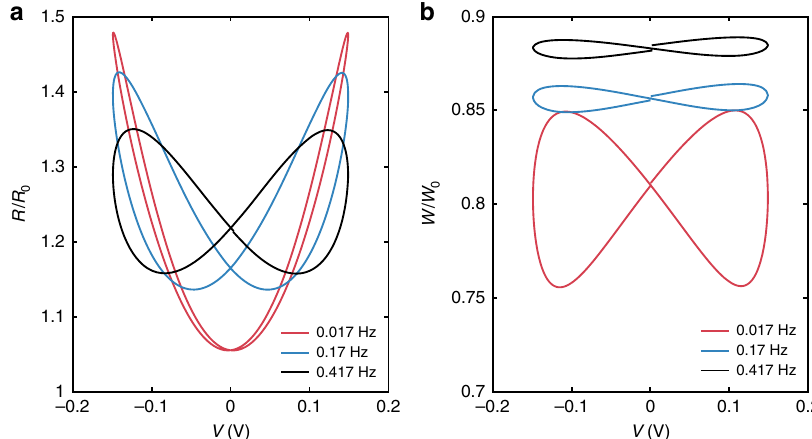
Fig. 7 Pinched hysteresis in state variable-voltage relationships. Simulations of a DPhPC membrane in decane subjected to a sinusoidal voltage show steady-state, pinched hysteresis in both bilayer radius ( a ) and thickness, ( b ). At the three frequencies, the results show that both state variables pinch at zero volts and that the amplitude of change for each state variable decreases as frequency increases. Membrane thickness, which exhibits slower dynamics compared to radius, exhibited greater sensitivity to frequency. These results highlight that the model enables tracking the contribution of each state variable to capacitive memory in the